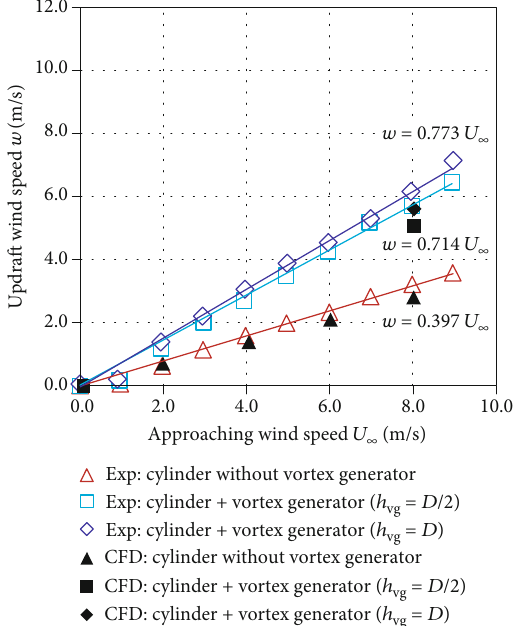
Figure 11: Updraft wind speeds in the case of the di ff user-shaped tower. The solid symbols represent the numerical results. The open symbols represent the experimental